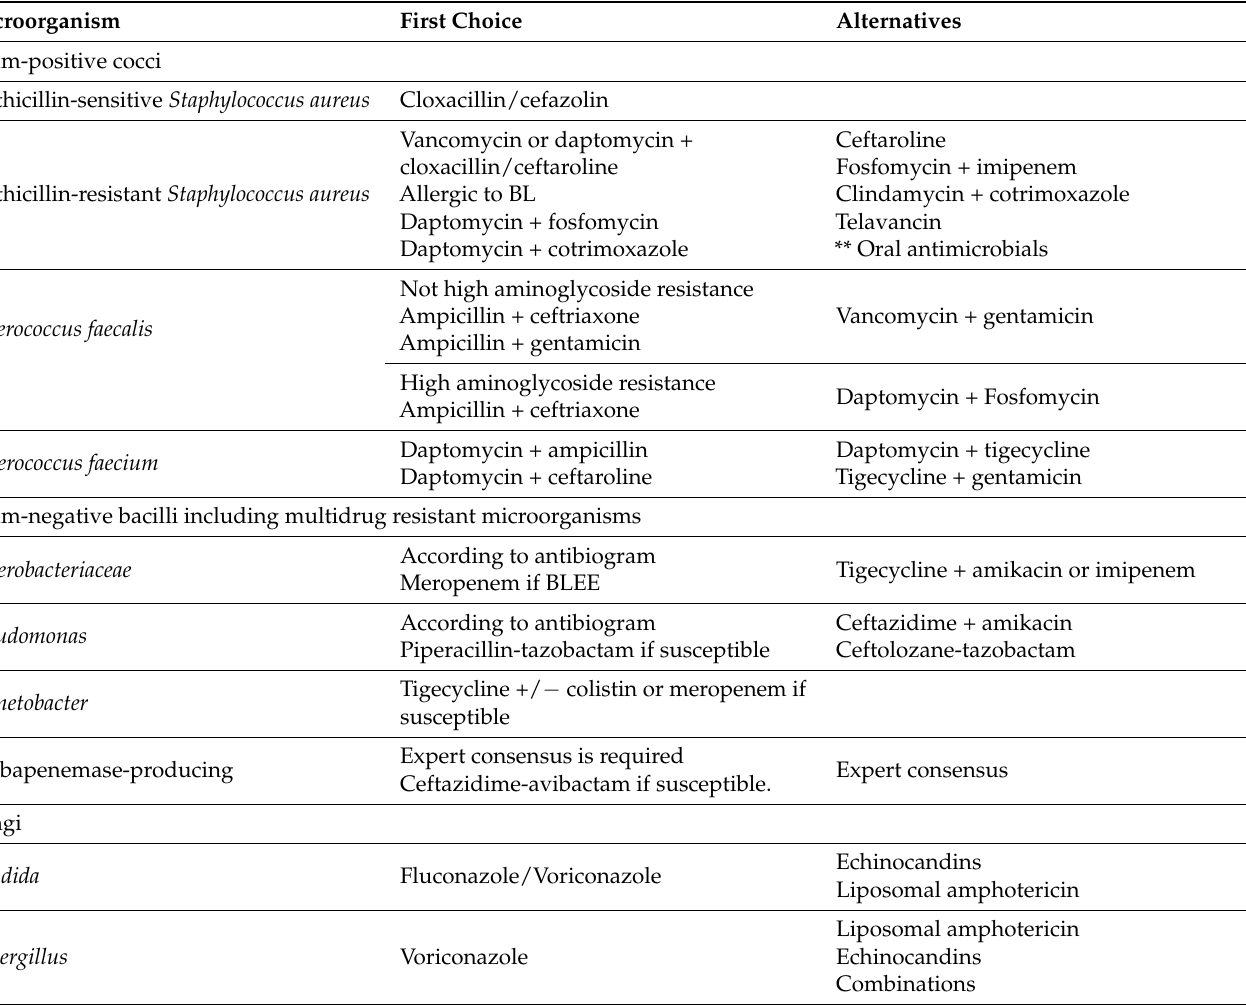
Table 4. Recommendations * for the treatment of mediastinitis as per the aetiological agent. Treatment must always be carried out with the advice of an expert in infectious diseases and adjusted to the sensitivity of each microorganism in each